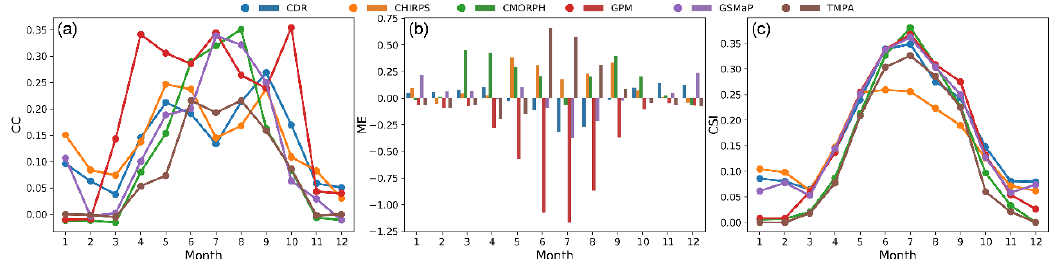
Figure 7. Distribution of the evaluation indexes in every month based on NW station daily data. ( a ) Correlation coefficient, ( b ) mean error, ( c ) critical success index.